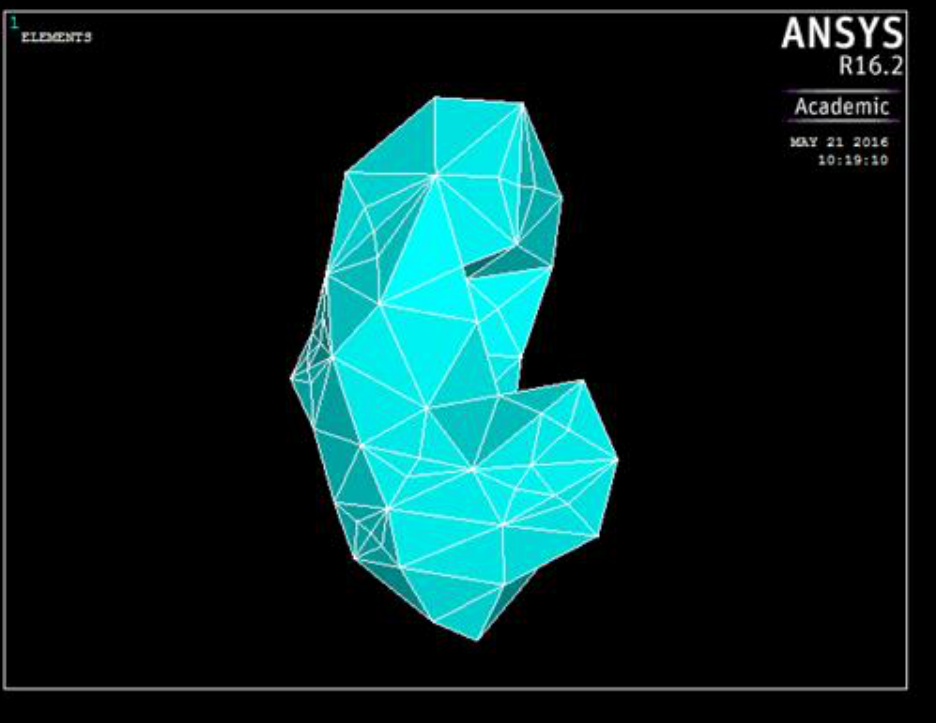
Figure 2. Discretized Geometry as Displayed in ANSYS.